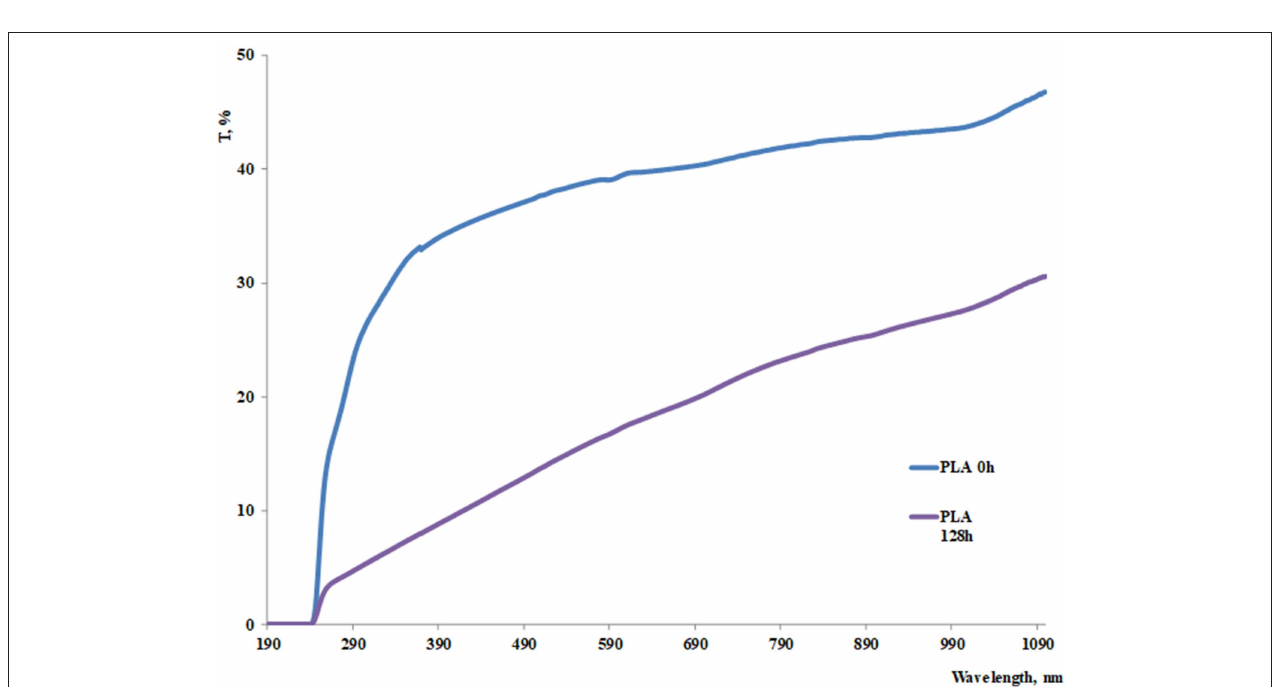
FIGURE 10 | UV spectra of pristine and 128 h-irradiated